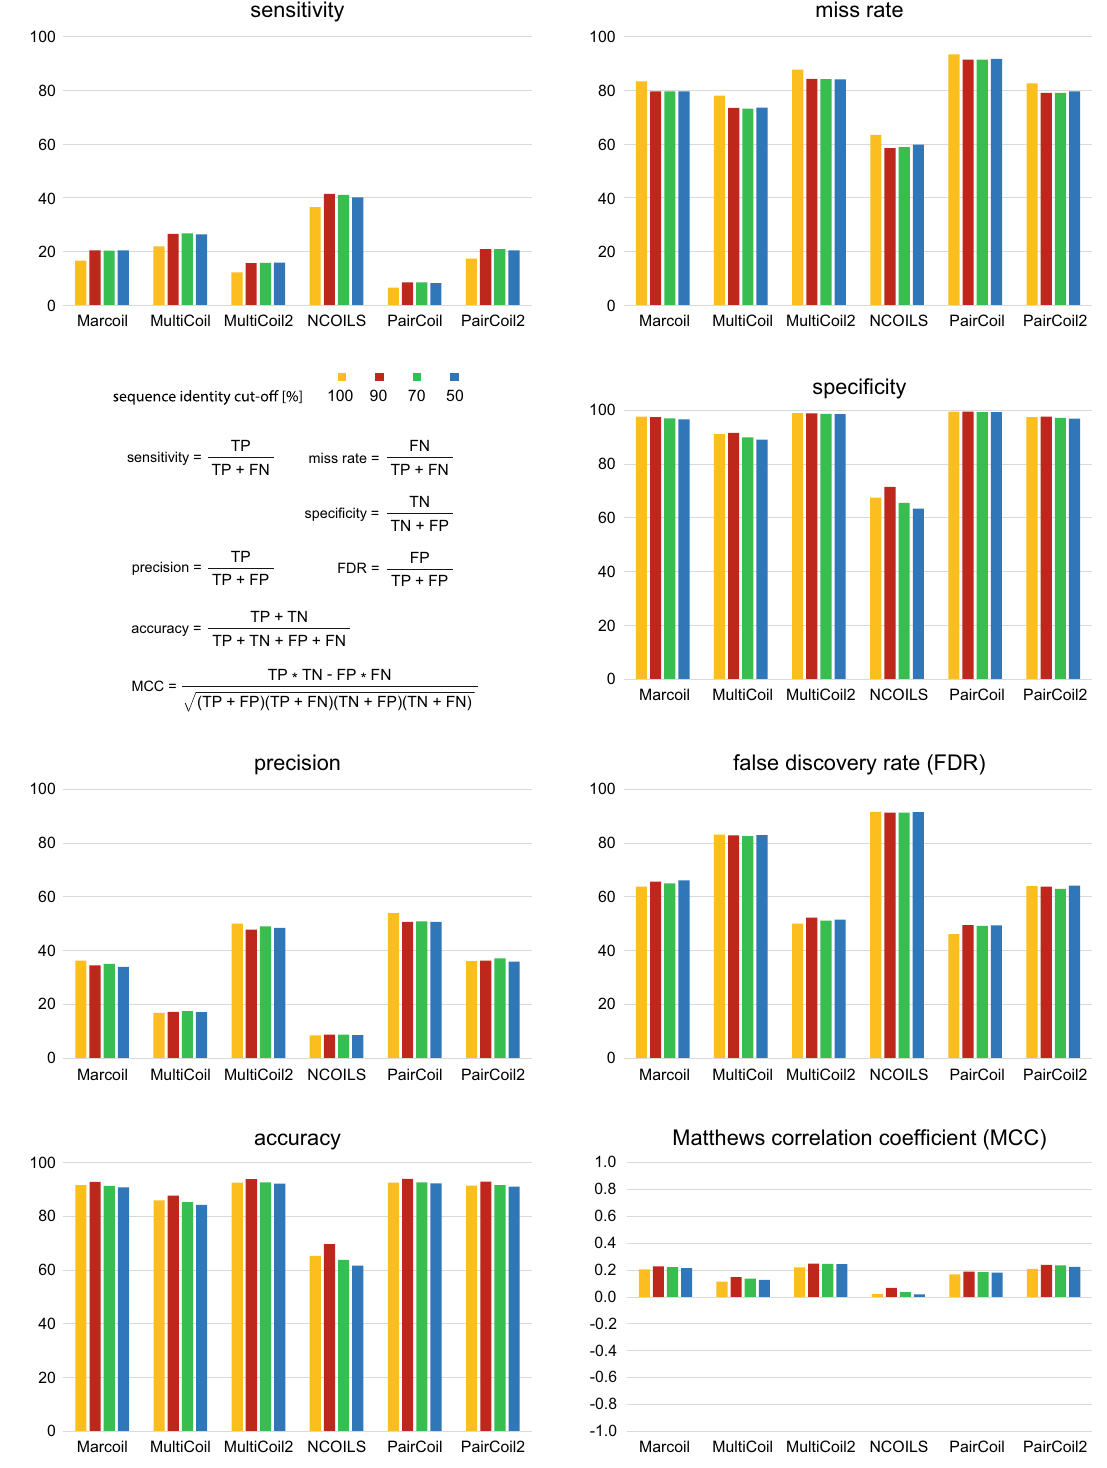
Figure 2. Performance of coiled-coil prediction tools in dependence of PDB sequence redundancy. The performance was analysed for four data sets with decreasing levels of sequence redundancy. With respect to these data sets, the sequences containing a coiled coil according to SOCKET are classified as positives while the remaining sequences represent the negatives. Based on the minimum requirement for overlap with these SOCKET hits (a single amino acid overlap), the coiled-coil predictions of the tools were categorized into four classes: true positives (TP = predictions overlap SOCKET hits), false positives (FP = predicted coiled coils do not overlap SOCKET hits), true negatives (TN = no prediction and no SOCKET hit in sequence), and false negatives (FN = no prediction in sequence region where SOCKET identified a coiled coil). The plots show the performance of the coiled-coil prediction tools based on commonly used statistical measures. A Matthews correlation coefficient (MCC) of + 1 indicates a perfect prediction, predictions with MCCs around 0 are no better than random, and a MCC of − 1 represents total disagreement between prediction and